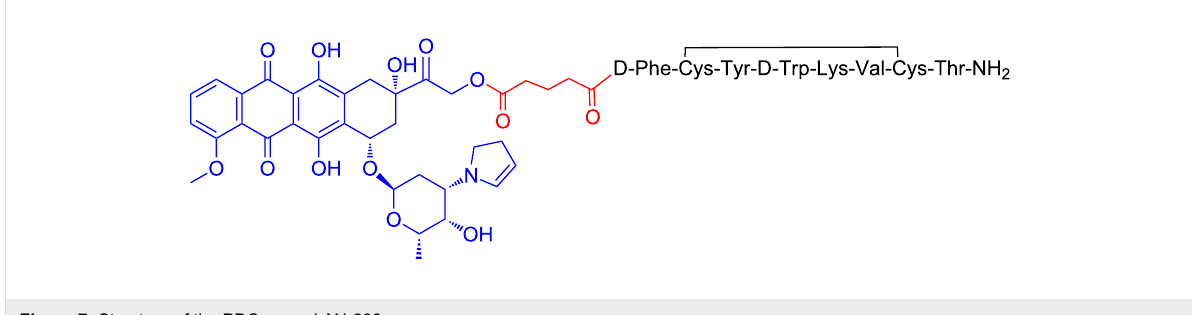
Figure 7: Structure of the PDC named